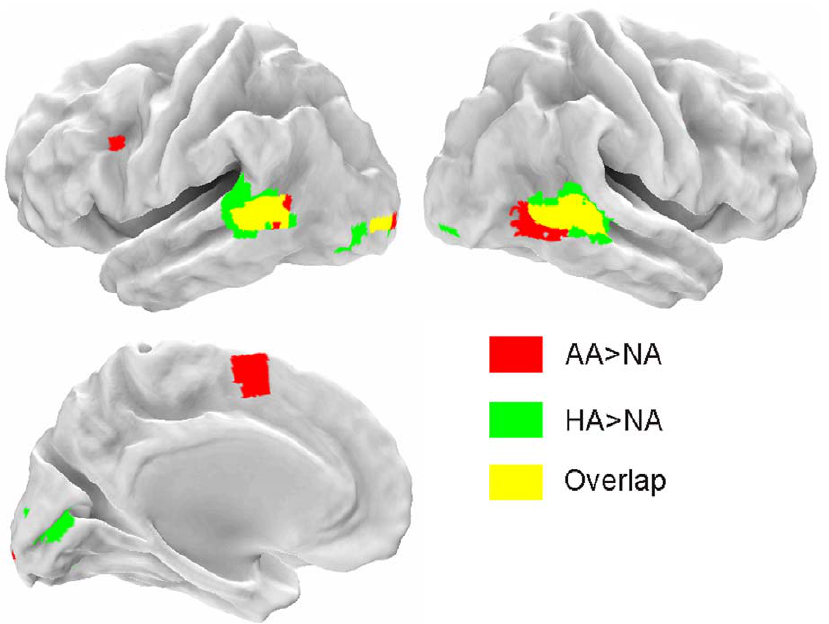
Figure 4. Action-Emotion . Action Neutral. Regions activated either in Angry Action Vs Neutral Action contrast (red) or in Happy Action Vs Neutral Action (green) contrast.